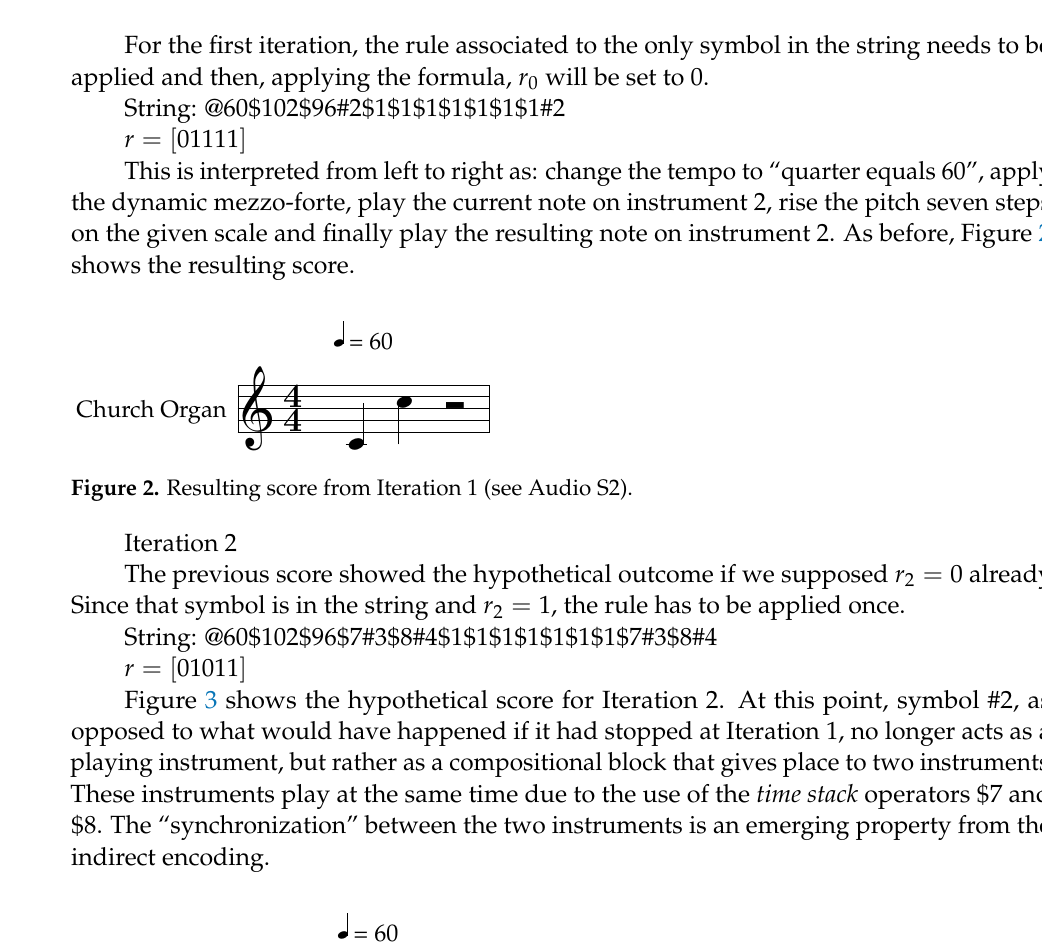
Figure 1. Resulting score from Iteration 0 (Audio S1).